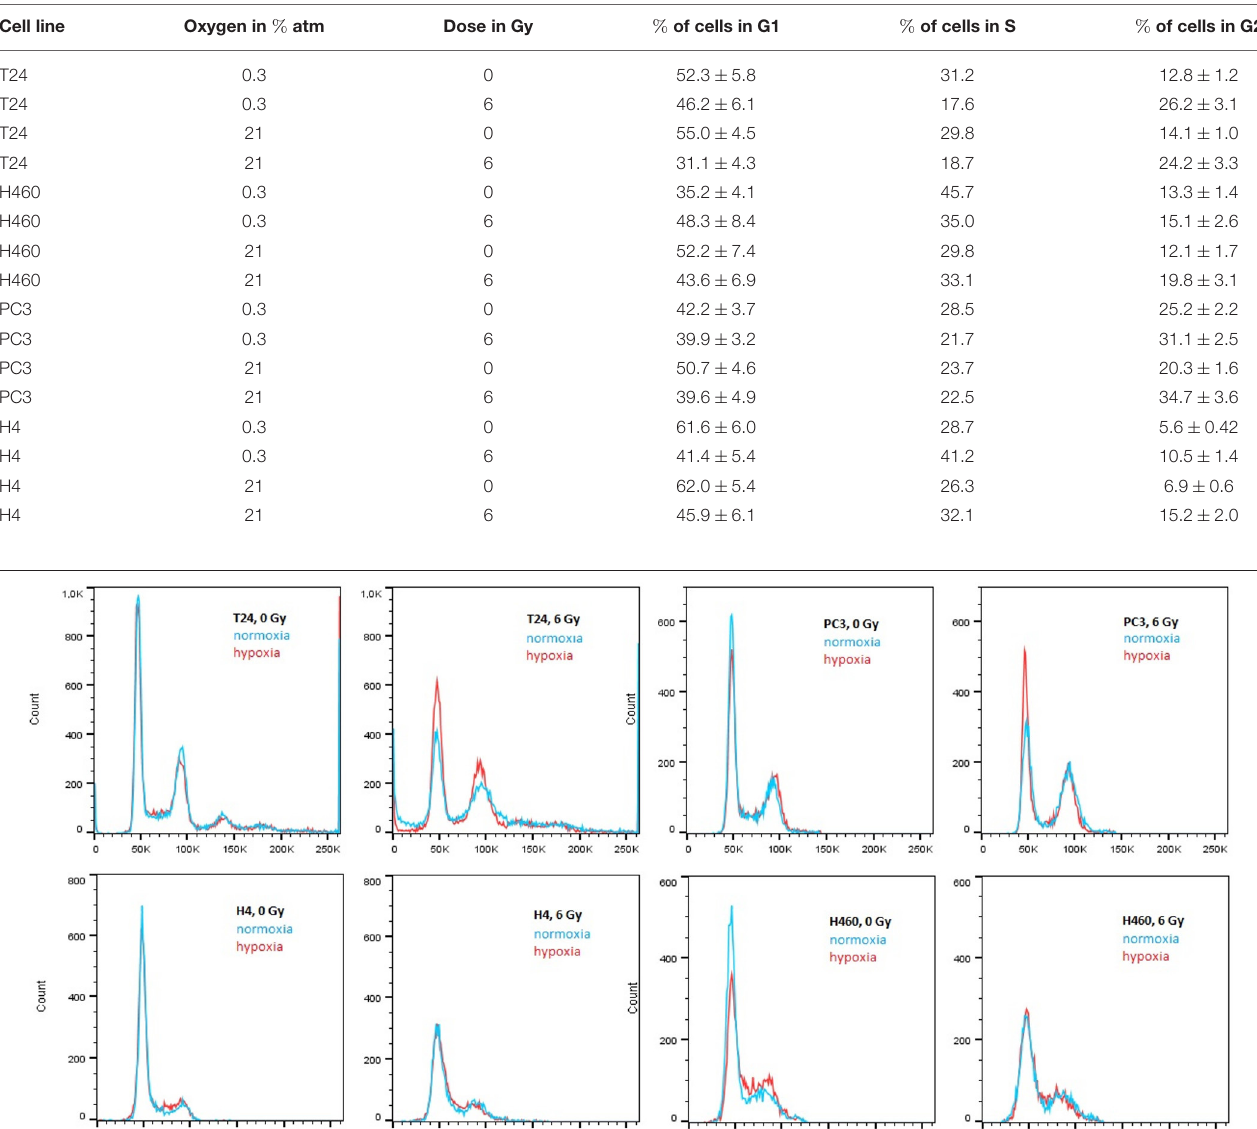
TABLE 1 | Percentage of cells per cell phase, obtained using the Watson algorithm on the spectra from Figure 4 . Cell line